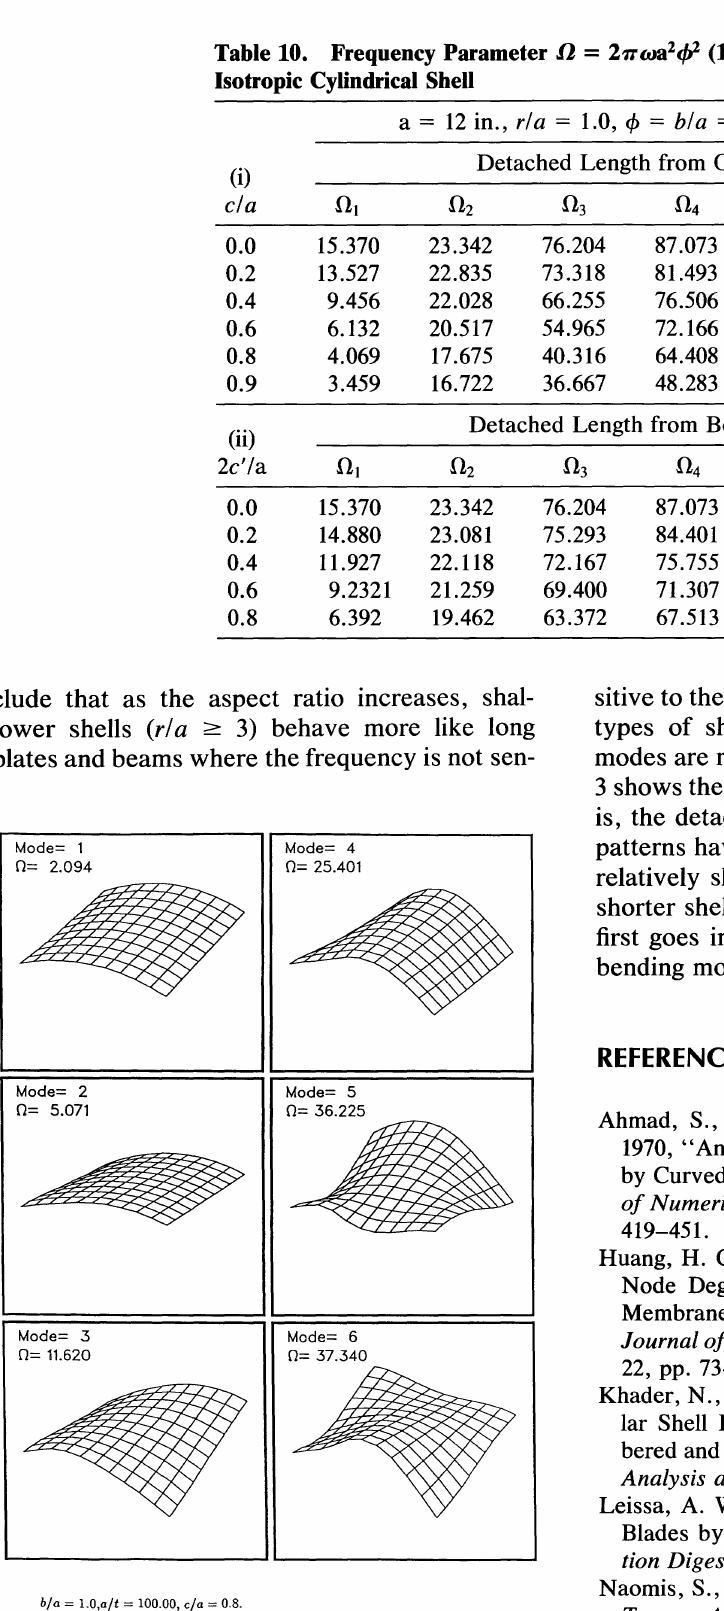
Table 10. Frequency Parameter Isotropic Cylindrical